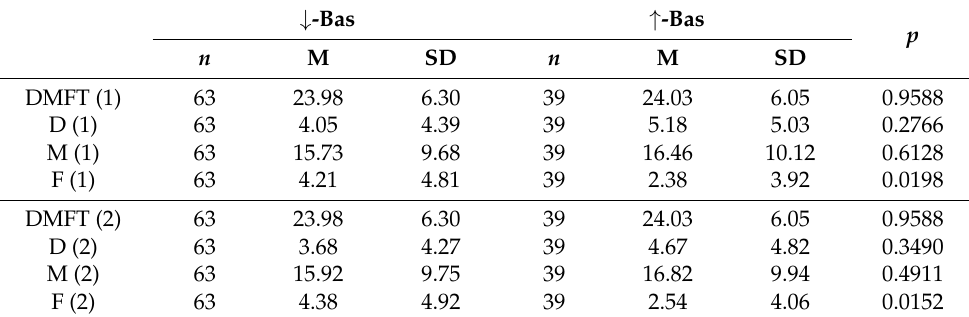
Table 8. Basophils count change and DMFT index before (1) and after (2)